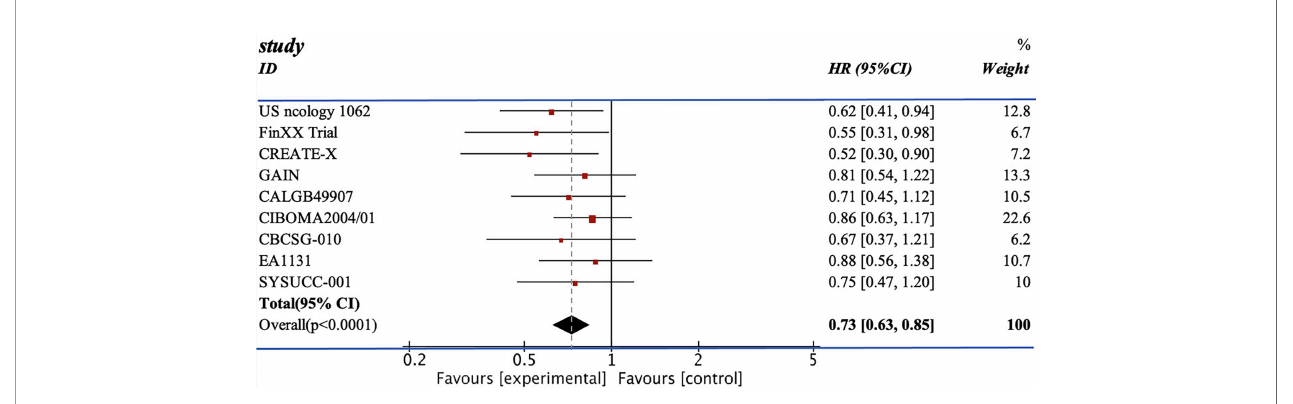
FIGURE 4 | The result of the